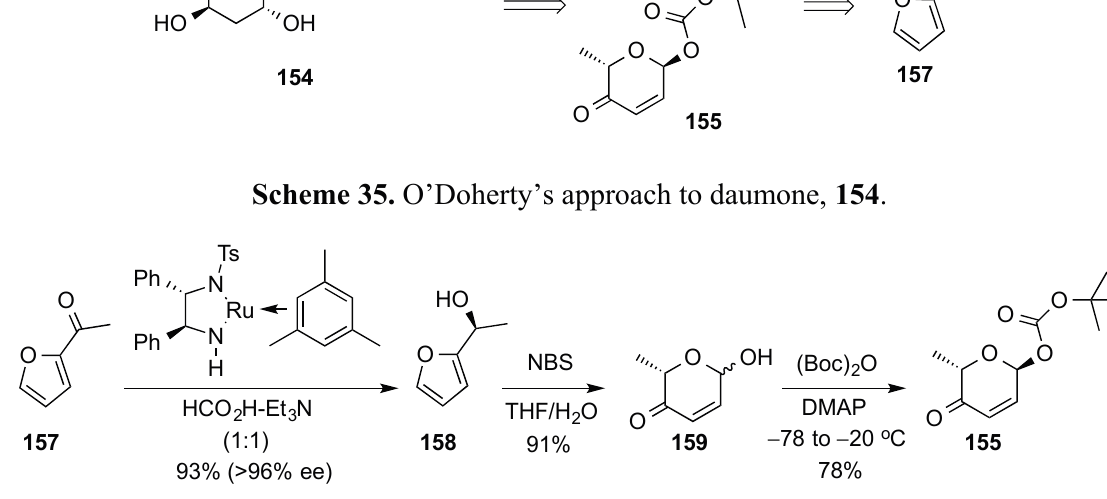
Scheme 36. Enantioselective synthesis of α -pyranone 155